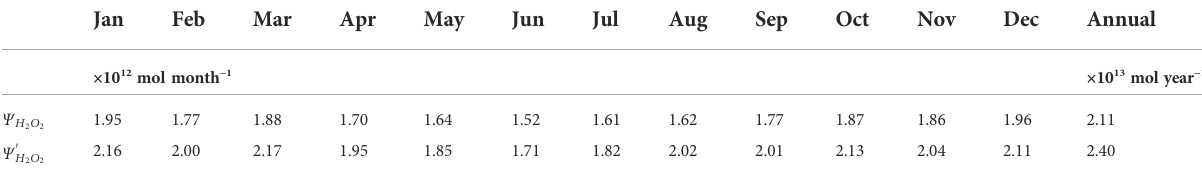
; Ψ 9 H ). Ψ H and Ψ H 2 O 2 2 O 2 2 O 2 2 O 2